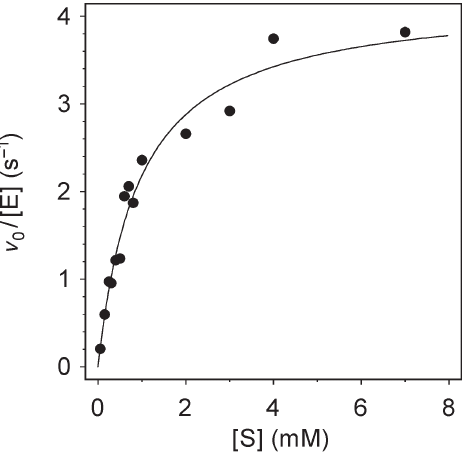
Figure 4. Kinetics of hydrolysis of Glc β 3Glc β -MU (1) catalyzed by 0.02 µM wild-type LamA from Pyrococcus furiosus in 100 mM phos- phate buffer, pH 6.5, at 80 °C. Abbreviations: v 0 = initial velocity; [E] = enzyme concentration; and [S] = substrate concentration.